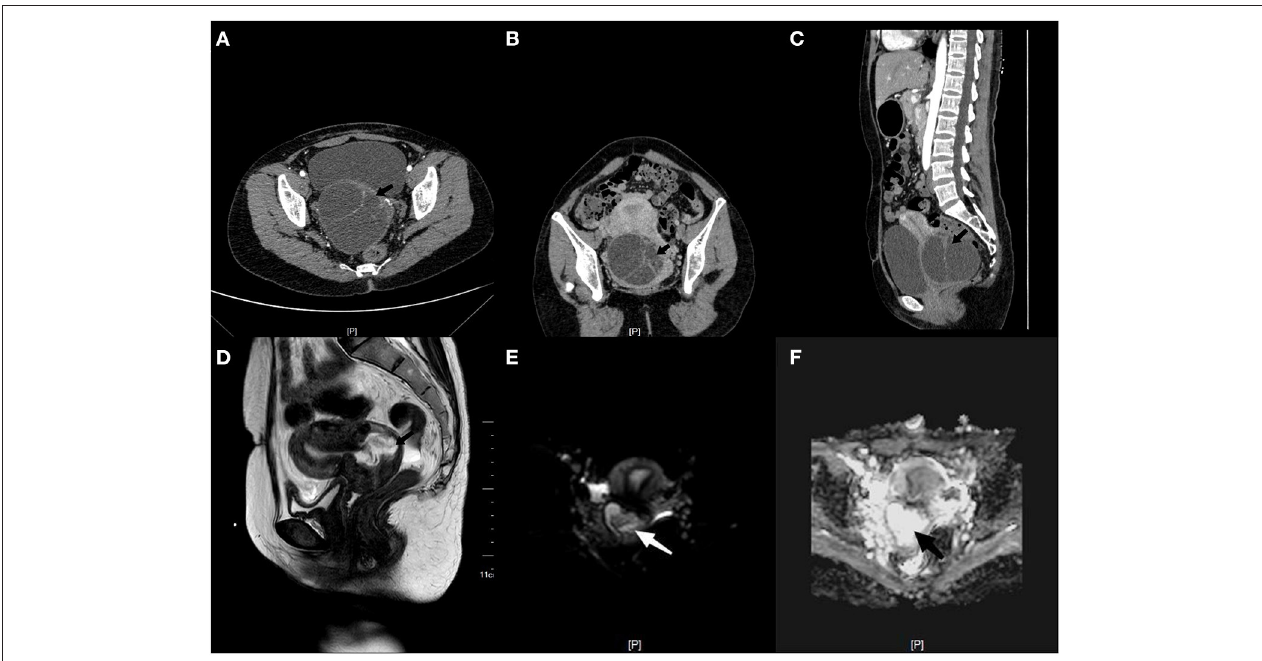
FIGURE 2 | Computed tomography showing the irregular shape of uterus. (A) There is a large abnormal density of multilocular cystic shadow, which is ∼ 8.8 × 8.5cm in size (black arrow). (B) There is an irregular separation in the cyst, and there is a close relationship between the uterus, cervix, and right appendix (black arrow). (C) Three-dimensional computed tomography reconstruction showing the cyst from below the posterior wall of the uterus to the posterior lip of the cervix (black arrow). (D) After cyst resection, additional MR examination showed irregular shape of posterior lip of cervix, size 4.1 × 2.3 × 4.7cm, inhomogeneous low signal on T1WI (black arrow). (E) Postoperative lesions under diffusion weighted imaging (white arrow). (F) Postoperative lesions in ADC images (black